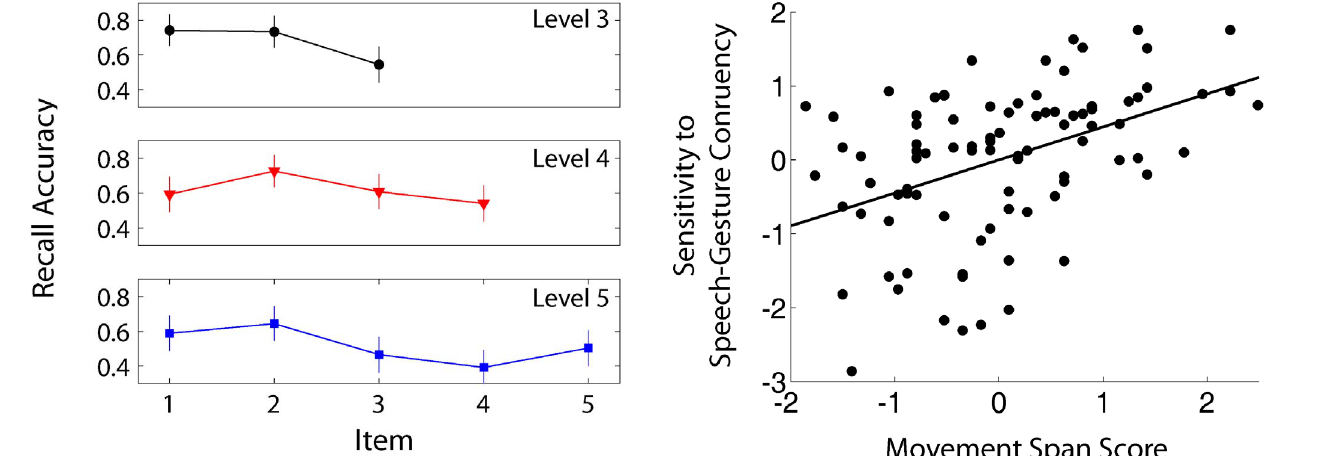
Figure 5. Zero-order correlation between d’ on gesture classification task and movement span scores. Sensitivity to gesture meaning increased linearly with increased capacity to remember and reproduce body movements.